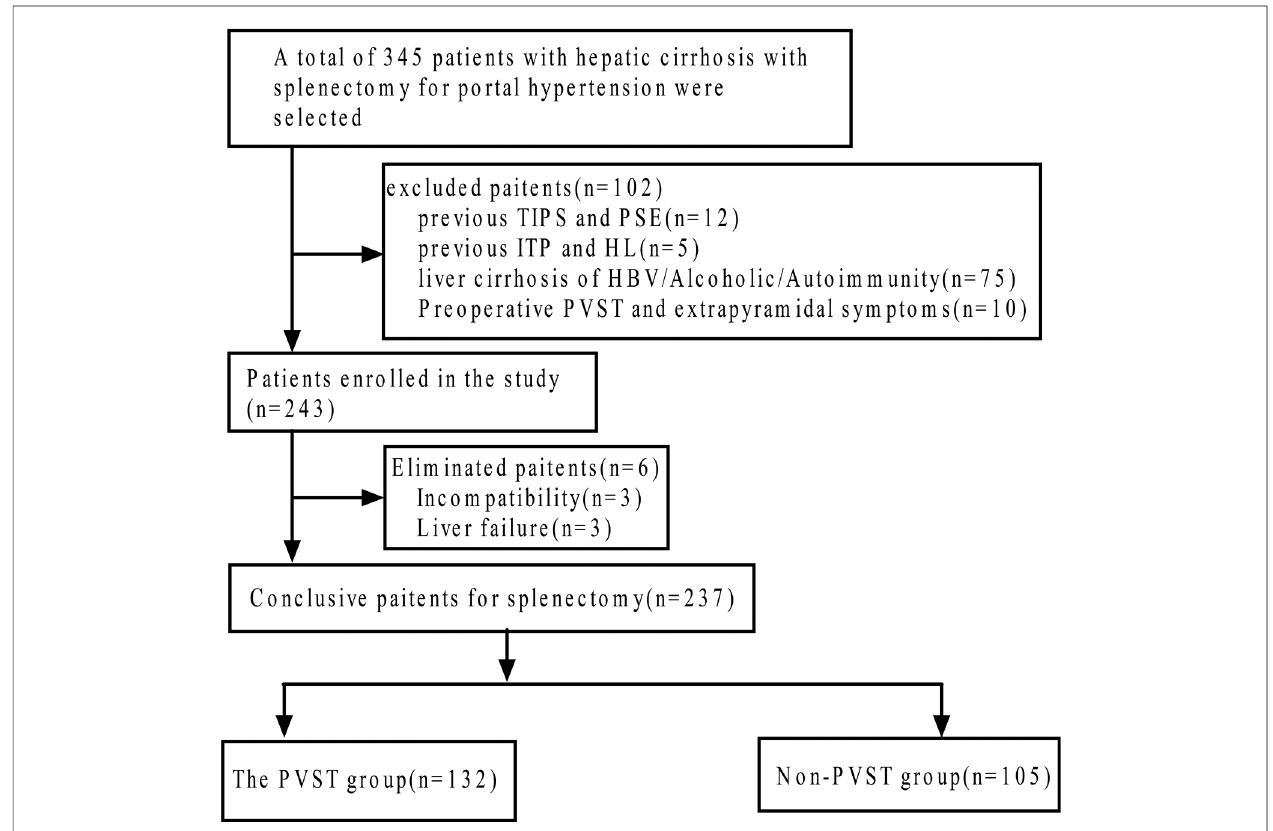
FIGURE 1 | Flow diagram of the study population. TIPS, transjugular intrahepatic portosystemic shunt; PSE, partial splenic embolization; ITP, idiopathic thrombocytopenic purpura; HL, Hodgkin lymphoma; HBV, hepatitis B virus; PVST, portal vein system thrombosis.